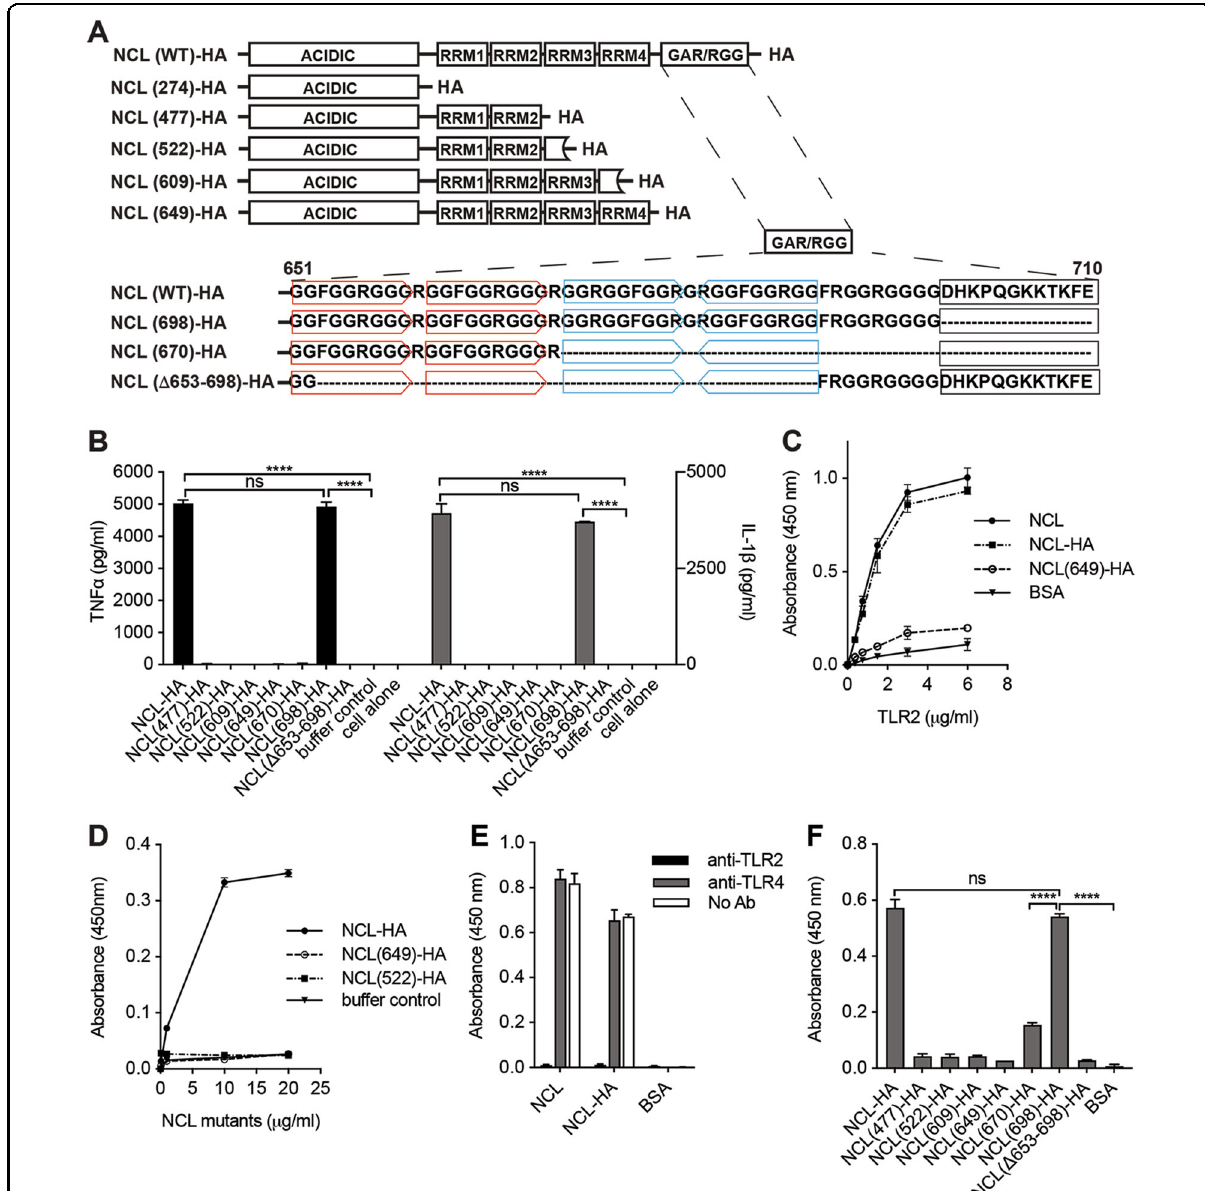
Fig. 3 The NCL alarmin activity resides in its GAR/RGG motif. A Recombinant NCL and its mutants. NCL mutants were generated by C-terminal deletion and the new C-termini are bracketed (i.e., 274, 477, 522, 609, 649, 670 and 698). Two head-to-head repeats in the GAR/RGG motif were highlighted in red boxes and two head-to-tail repeats were identi fi ed in cyan boxes. Deletion of these four repeats yields another mutant ( Δ 653-698). Recombinant NCL and its mutants were expressed in 293T cells with C-terminal HA tags. B Monocytes were stimulated with coated NCL-HA and its mutants (40 μ g/ml) for 24 h to measure TNF α and IL-1 β production. Triplicate experiments were performed to obtain data as mean ± SD. Data were analyzed by one-way ANOVA. C NCL, NCL-HA, NCL(649)-HA, and BSA (10 μ g/ml) were coated to incubate with TLR2-10xHis (0.375 – 6.0 μ g/ml). Bound TLR2 was detected using a mouse anti-His antibody (2.6 μ g/ml). D TLR2 (2 μ g/ml) was coated to incubate with NCL-HA, NCL(649)-HA, or NCL(522)-HA (0 – 20 μ g/ml). Bound NCL-HA and its mutants were detected using a mouse anti-HA antibody (1 μ g/ml). E TLR2 (2 μ g/ml) was coated, pre-incubated with TLR2 or TLR4-blocking antibodies (5 μ g/ml), and incubated with NCL, NCL-HA or BSA (10 μ g/ml). Bound proteins were detected using a rabbit anti-NCL antibody (1 μ g/ml). F Binding of NCL-HA and its mutants to TLR2. NCL-HA, its mutants, and control BSA were plate-coated (10 μ g/ml) to incubate with TLR2 (2 μ g/ml). Bound TLR2 was detected using the mouse anti-His antibody. In these experiments, HRP-conjugated secondary antibodies were used. Triplicate experiments were performed to obtain data as mean ± SD. Data was analyzed by one-way ANOVA. * p < 0.05, *** p < 0.001, **** p < 0.0001. n.s., not signi fi